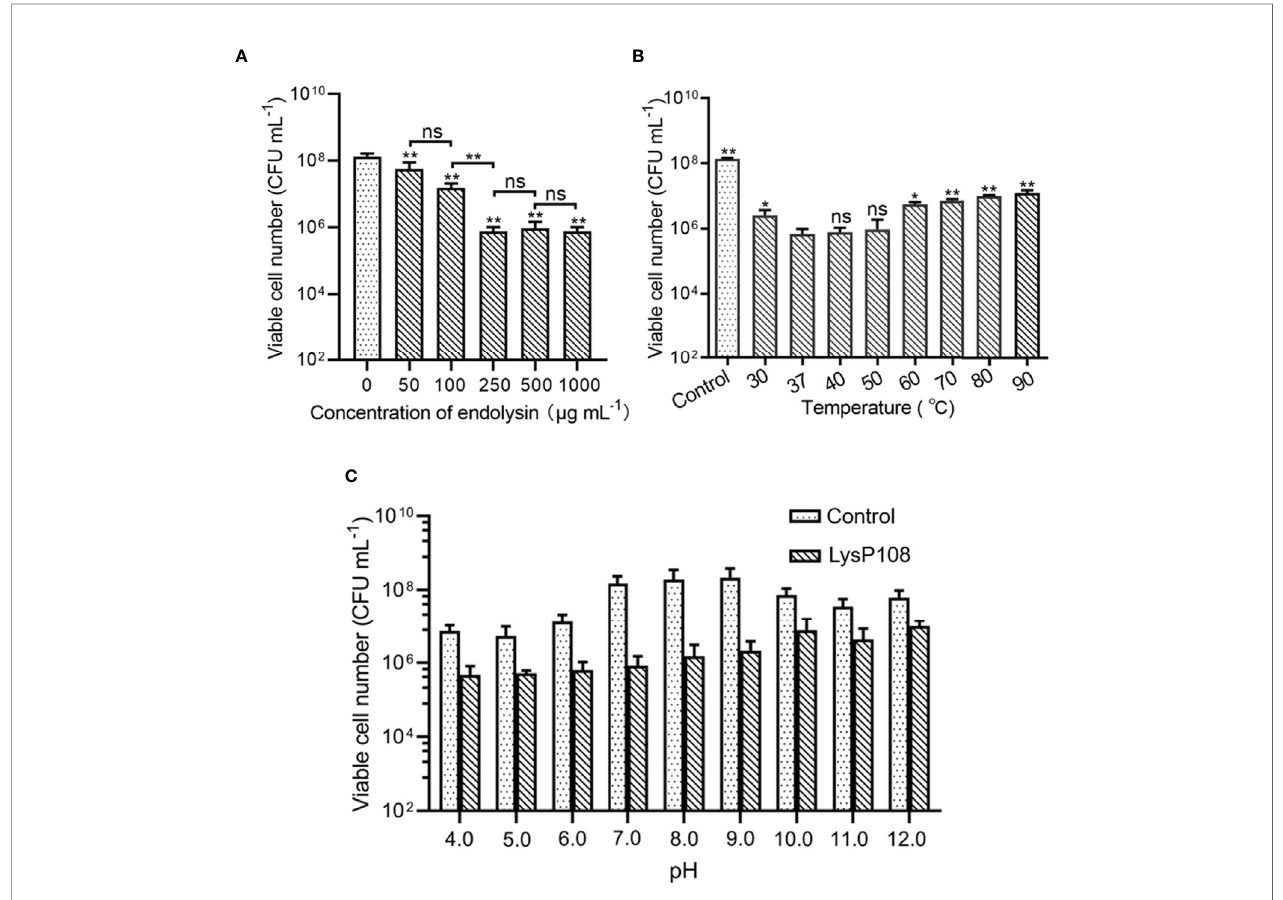
FIGURE 3 | Determination of the optimum conditions for the lytic activity of endolysin LysP108: (A) concentration (n=3), (B) temperature (n=3), and (C) pH (n=3). * P < 0.05, ** P < 0.01, and ns, not signi fi